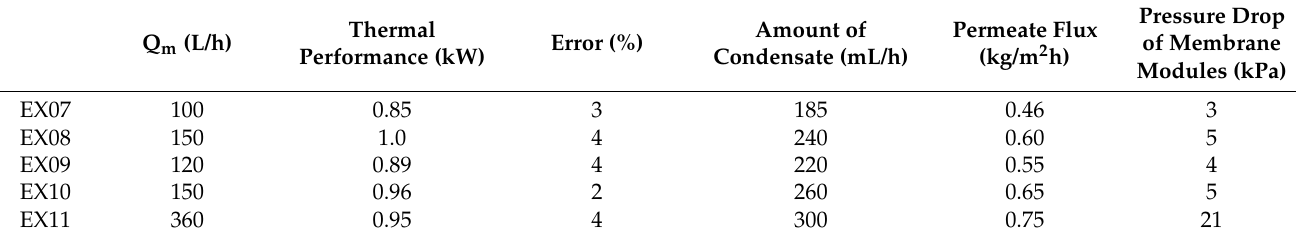
Table 5. Thermal performance, measurement error, condensate amount, permeate flux, and membrane module pressure drop for combination of MM004 and MM007 and two